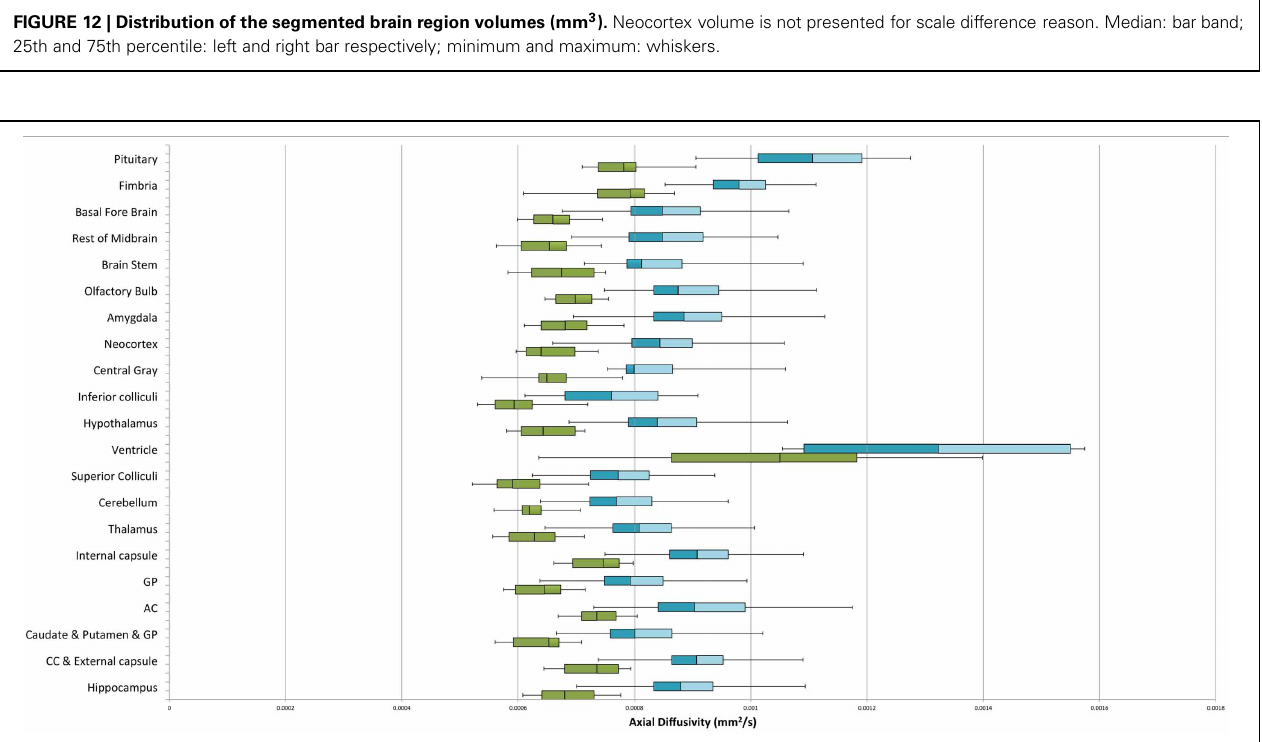
FIGURE 13 | Axial diffusivity (mm 2 /s) of the segmented brain regions. Median: bar band; 25th and 75th percentile: left and right bar respectively; minimum and maximum: